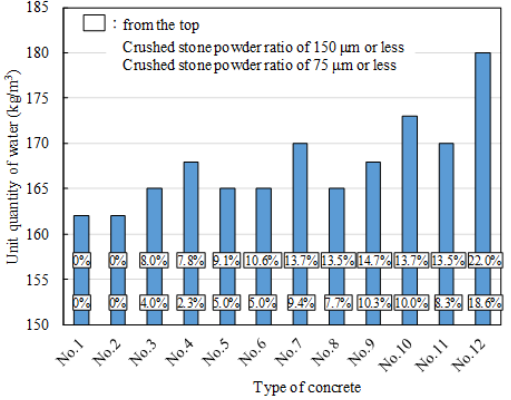
Figure 4. Amount of crushed stone powder of 150 µ m or less for each mix proportion.